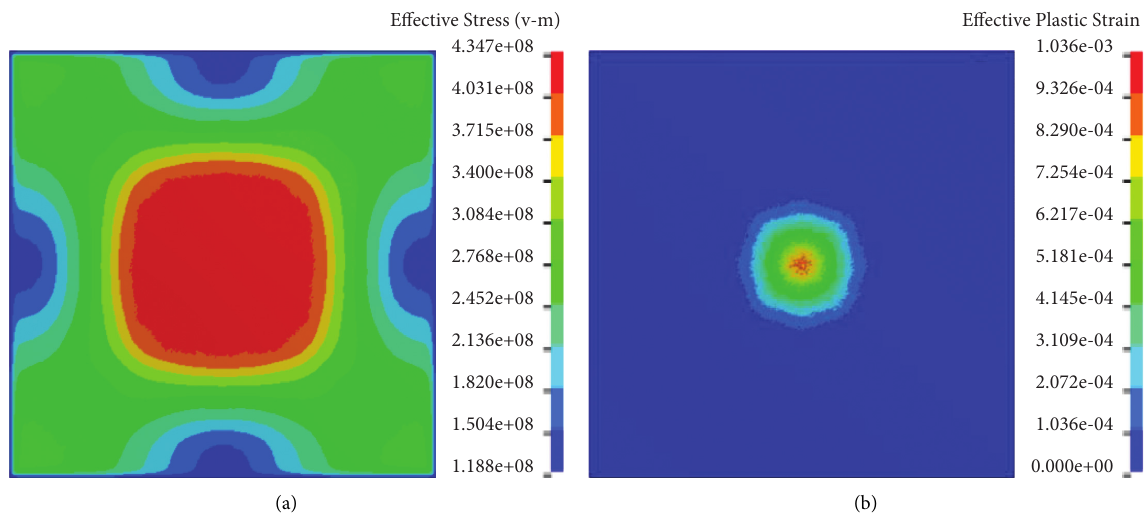
Figure 11: (a) von Mises stress and (b) effective plastic strain of the